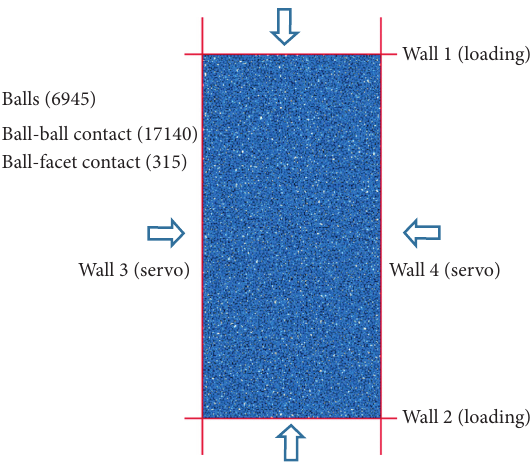
Figure 1: The established numerical